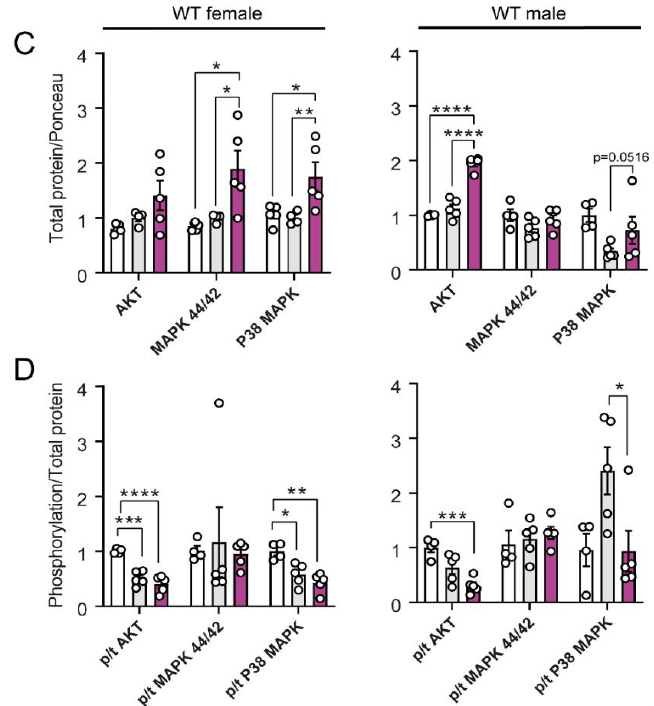
Figure 5. Abundance of growth and metabolic signalling proteins in placental labyrinth of WT conceptuses in response to littermate and/or maternal p110 α deficiency. Female ( A ) and male ( B ) representative images from each antibody immunodetection and Ponceau staining for phosphorylated and total AKT, AMPK α , MAPK 44/42, and P38 MAPK. Total AKT, AMPK α , MAPK 44/42, and P38 MAPK protein levels in females and males ( C ), and AKT, AMPK α , MAPK 44/42, and P38 MAPK phosphorylation levels as a ratio to total protein in females and males ( D ). Data are from 1 WT fetus per dam generated by WT x WT ( n = 4), WT x α /+ ( n = 5), and α /+ x WT ( n = 5) parental crosses and are displayed as individual data points with mean ± S.E.M. Data were analysed by one-way ANOVA with Tukey post hoc pairwise comparisons (* p < 0.05, ** p < 0.01, *** p < 0.001, **** p < 0.0001, pairwise comparison). p = phosphorylated, t = total.